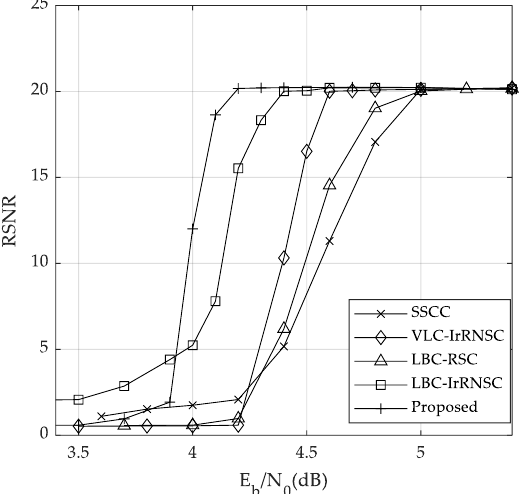
Figure 8. The RSNR performance of different systems over the AWGN channel.